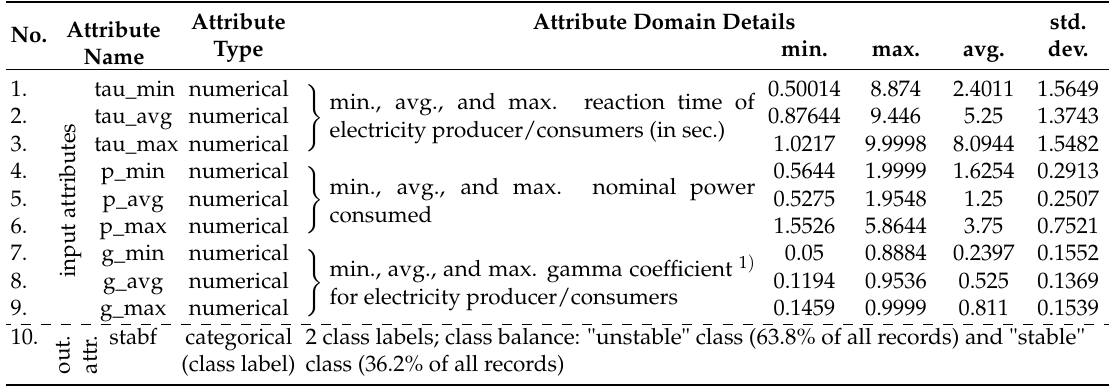
Table 2. Details of particular records of the input-aggregate-based version of the Electrical Grid Stability Simulated Data Set (referred to as the Concise Simulated Data Set ) used in our